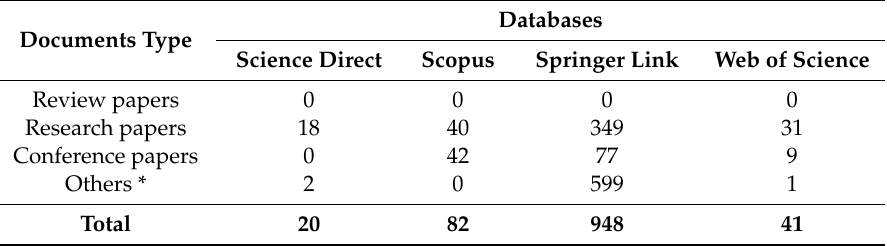
Table 3. Preliminary result of the review of thermal comfort in buses per